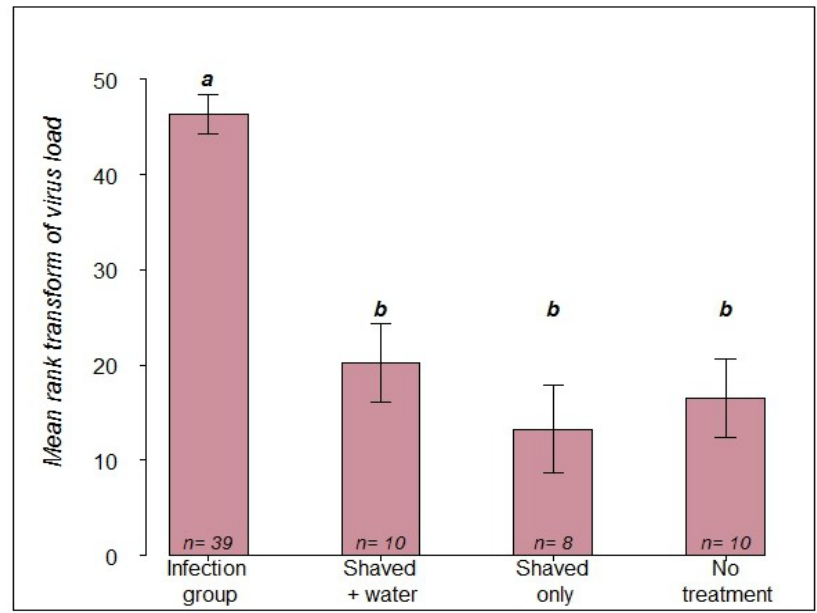
Figure 2. Comparison of mean rank transformed viral load among the infection group and the three control groups based on the LSD test. Means with common letters are not significantly different p ≤